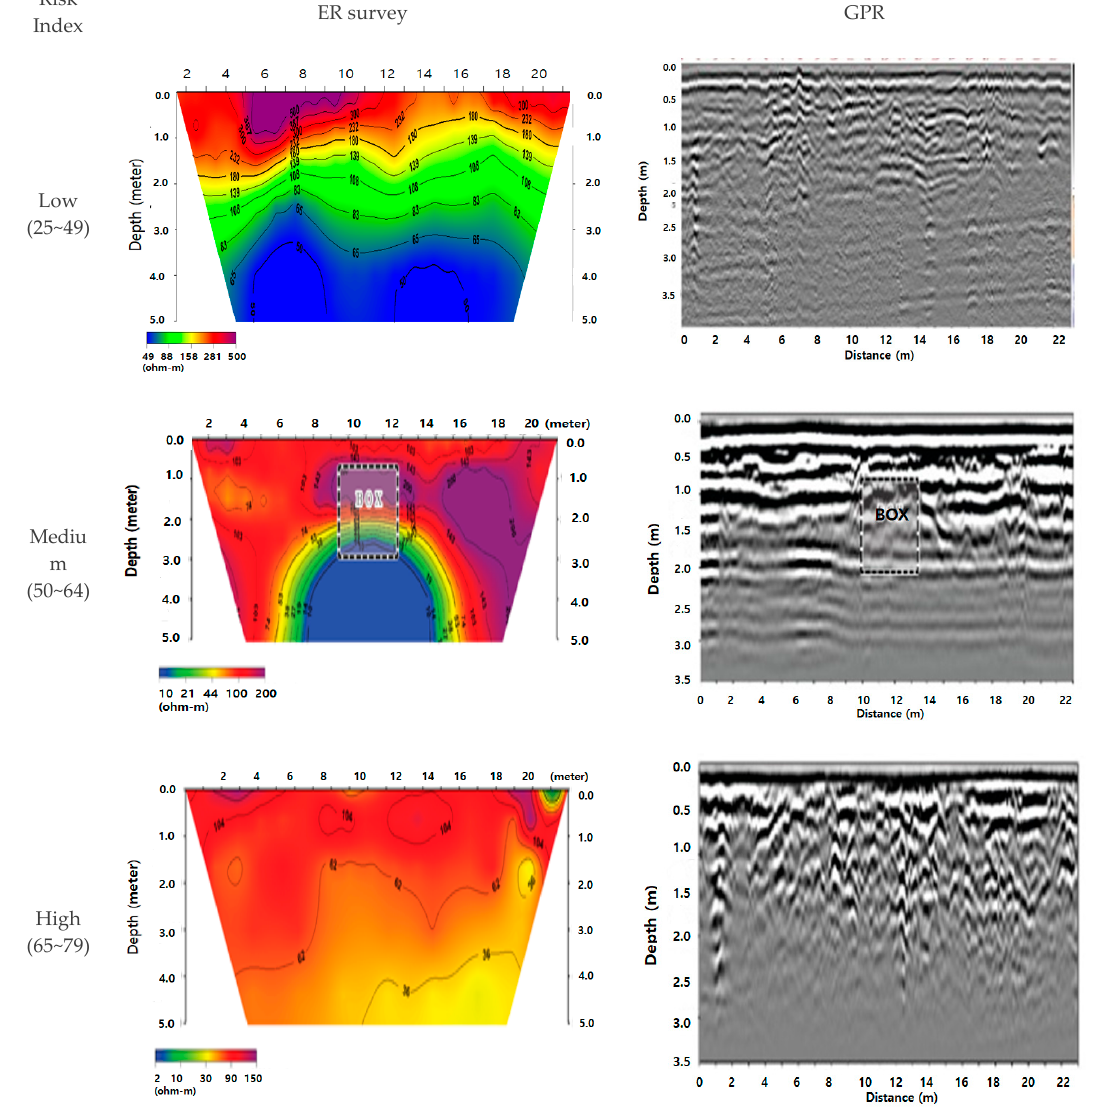
Figure 8. Examples of nondestructive test results.